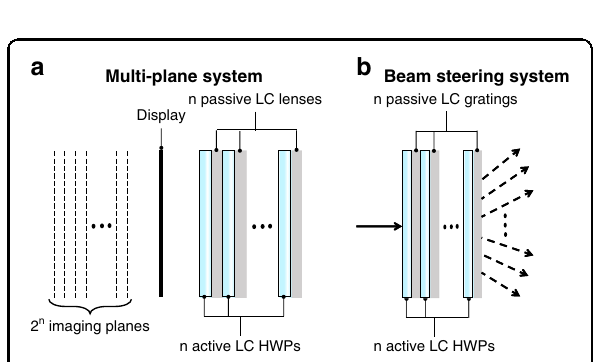
Fig. 9 Applications of LC wave plate in AR/VR. a Multiplane system con fi guration. b Beam steering system con fi